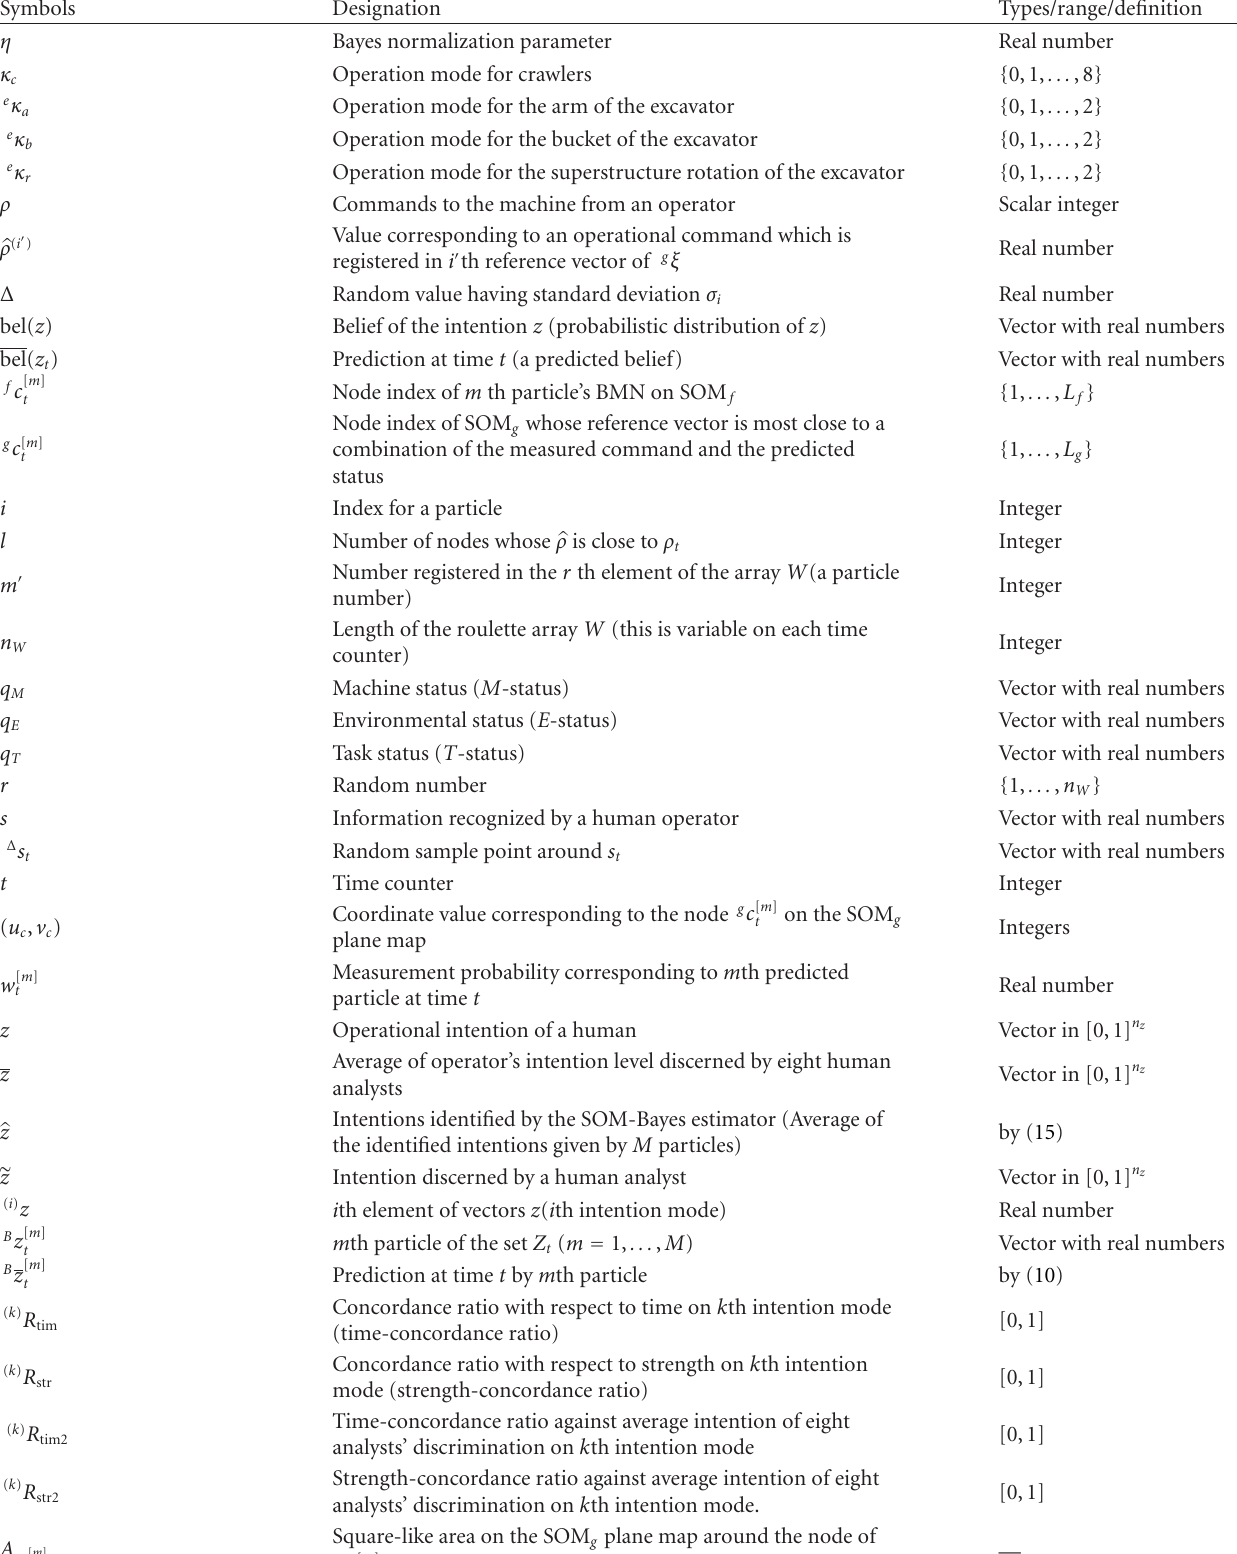
Table 4: List of